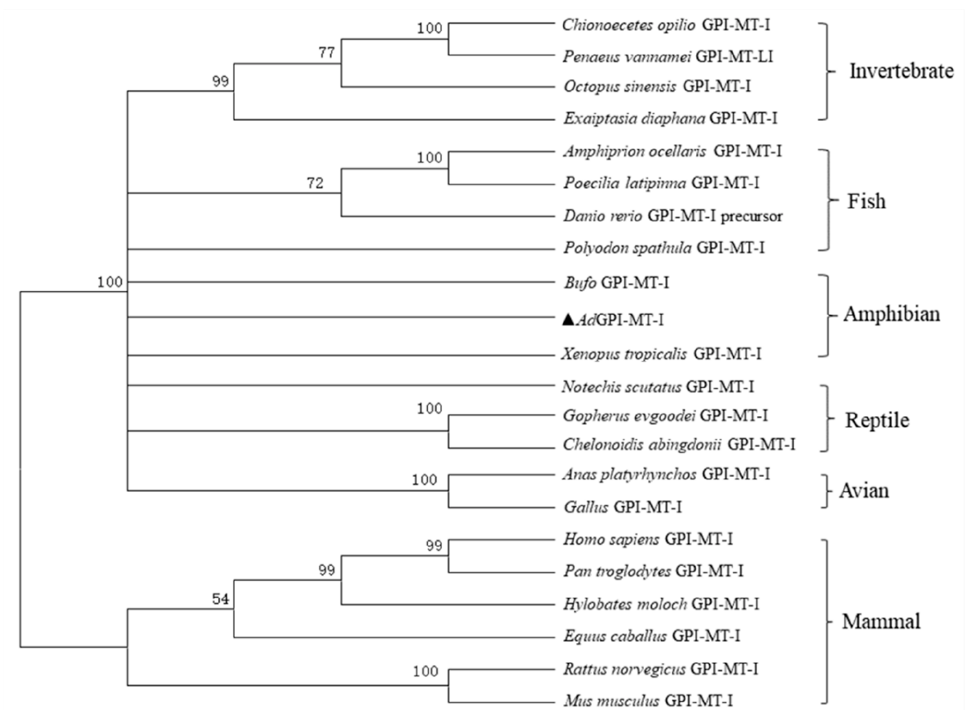
Figure 3. Phylogenetic relationships between GPI-MT-I genes in different species. Amino acid sequences of GPI-MT-I genes were deduced from GenBank, and the phylogenetic tree was constructed with the neighbor-joining method in MEGA7.0 software. Numbers beside the internal branches indicate bootstrap values based on 1000 replications. AdGPI-MT-I is highlighted with a triangle symbol ( (cid:78)